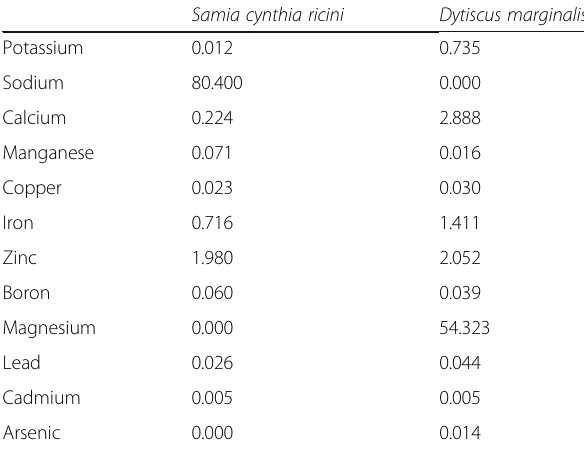
Table 3 Mineral contents of the studied insects